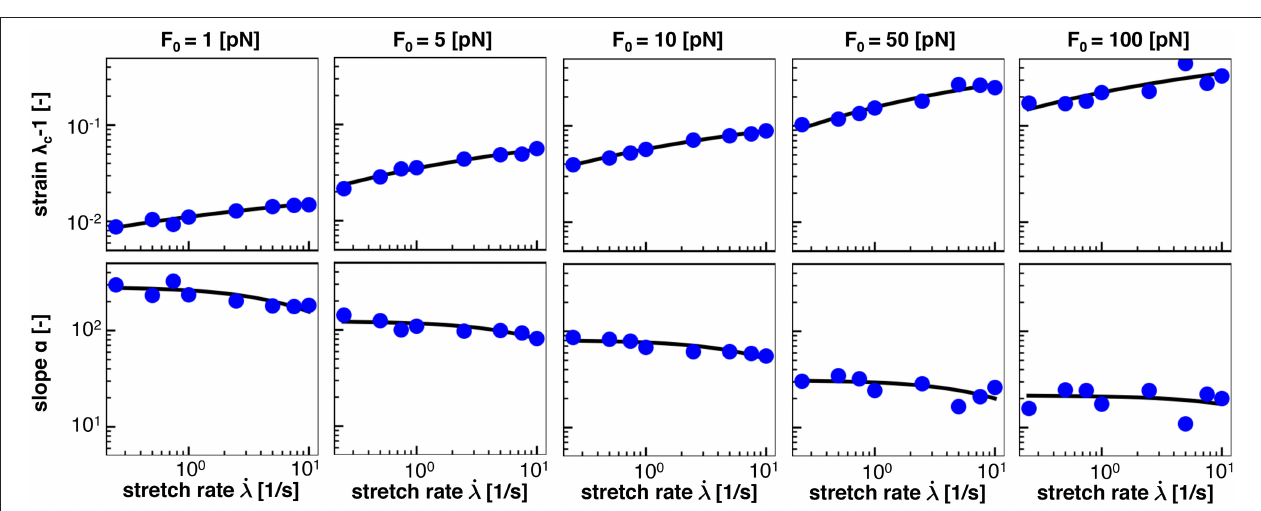
FIGURE 8 | Homogenization of half damage stretch λ 50 and damage slope α from average response of n = 10 discrete axonal damage simulations for as function of the stretch rate, ˙ λ , for five bond strengths, F 0 . Blue dots represents λ 50 and α values from the average damage vs. stretch relations in Figure 6 ; solid black lines represent homogenization using Equations (19) and (20) for five bond strengths, F 0